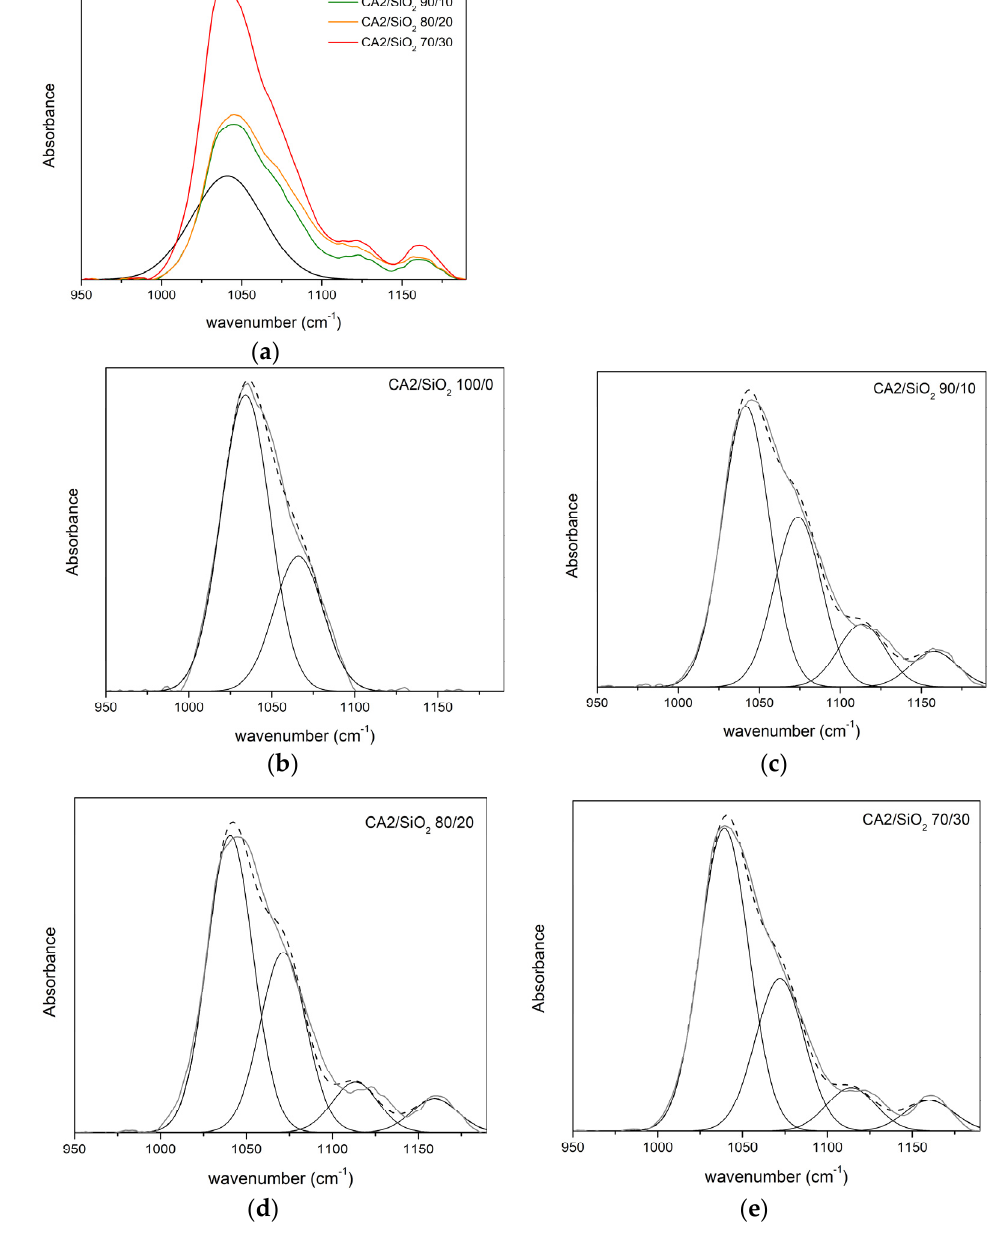
Figure 8. FTIR-ATR absorption spectra of series two membranes: CA2/SiO 2 100/0, CA2/SiO 2 90/10, 80/20, and 70/30: ( a ) In the region 950–1190 cm -1 and ( b – d ) curve- fi tt ing decomposition of the ν δ (C- O), ν δ (Si-O-Si) and ν (Si-O-C) bands, present in the spectra obtained for: ( b ) CA2/SiO 2 100/0 mem- brane, ( c ) CA2/SiO 2 90/10 membrane, ( d ) CA2/SiO 2 80/20 membrane, and (e) CA2/SiO 2 70/30 mem- brane. Experimental results are shown by the thick grey line and the simulated band by the black dashed line. Table 3. Series two: frequency ( ν ) and relative area (A %) of the bands ν δ (C-O), ν δ (Si-O-Si), and ν δ (Si- O-C).